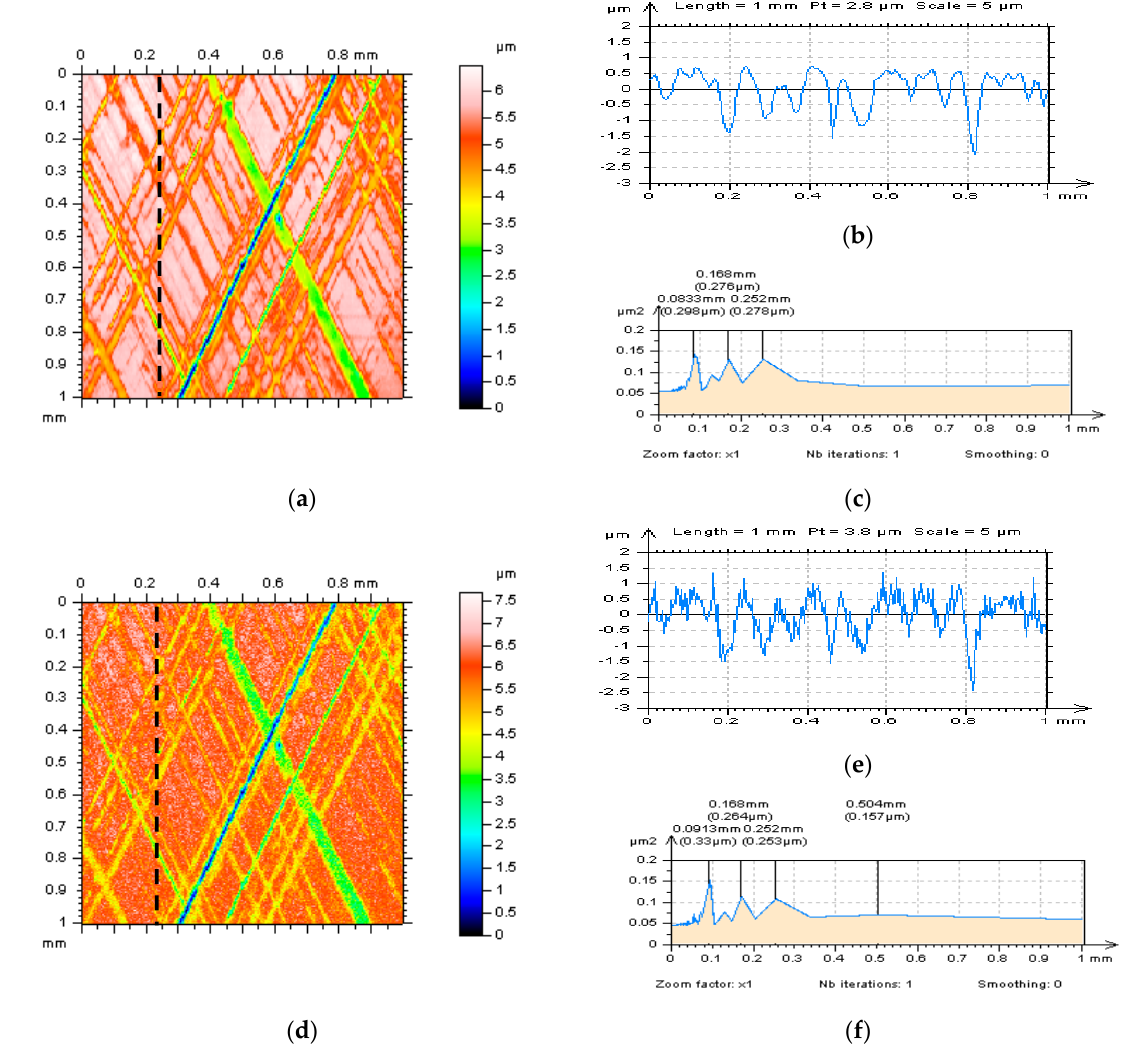
Figure 8. Isometric views of cylinder liner plateau-honed surface texture measured with 0.3 mm/s ( a ) and 0.7 mm/s ( d ) velocities with vertically extracted profiles ( b , e ), indicated by the dash lines in the views of measured detail, and their PSDs ( c , f ) correspondingly.